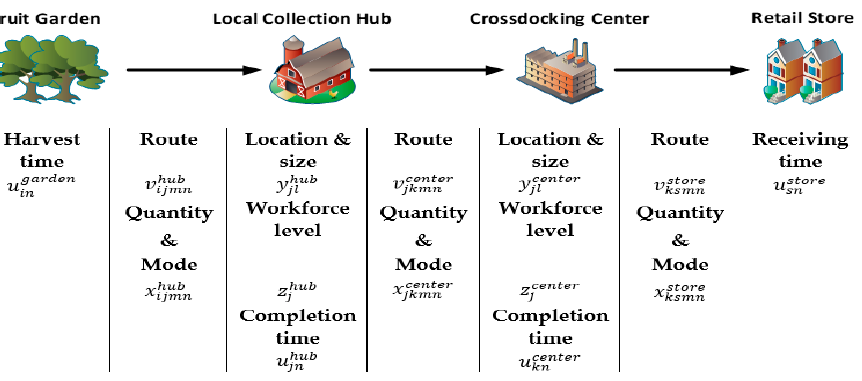
Figure 2. Supply chain configuration variables.